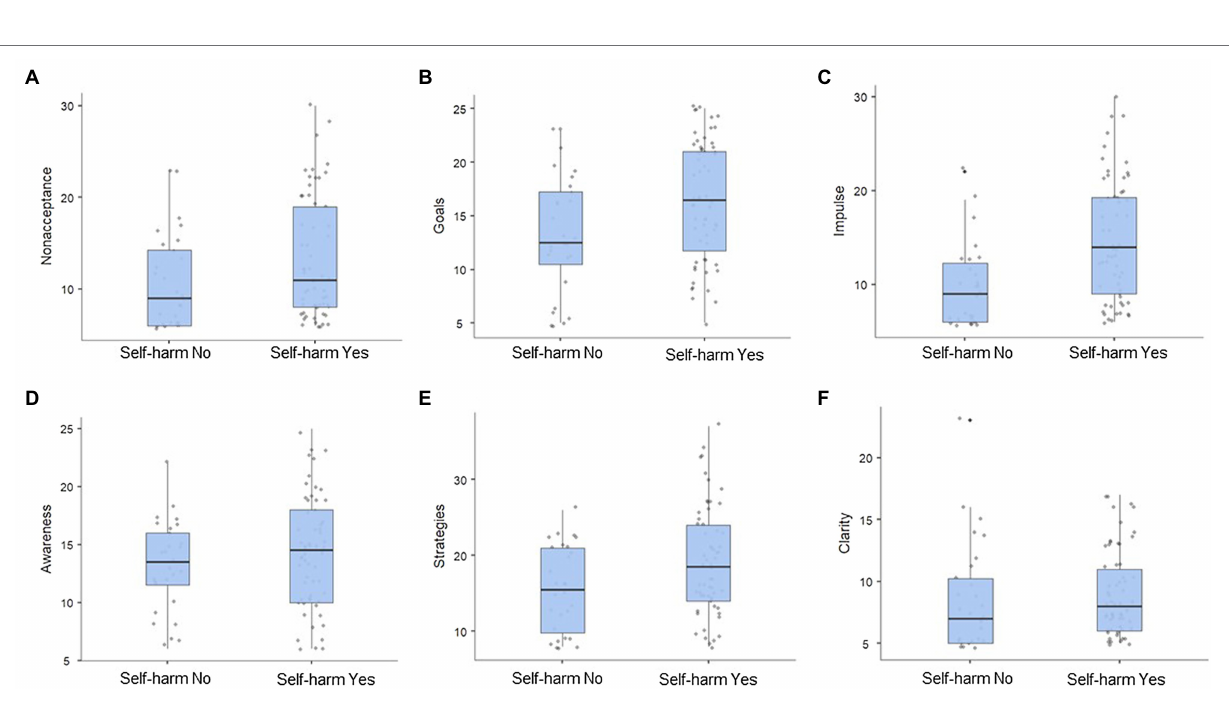
FIGURE 2 | Distribution of median values on the DERS subscales in forensic psychiatric patients with ( n = 67) and without self-harm ( n = 61). * (A) = Non- acceptance; (B) = Goals; (C) = Impulse; (D) = Awareness; (E) = Strategies; and (F) =